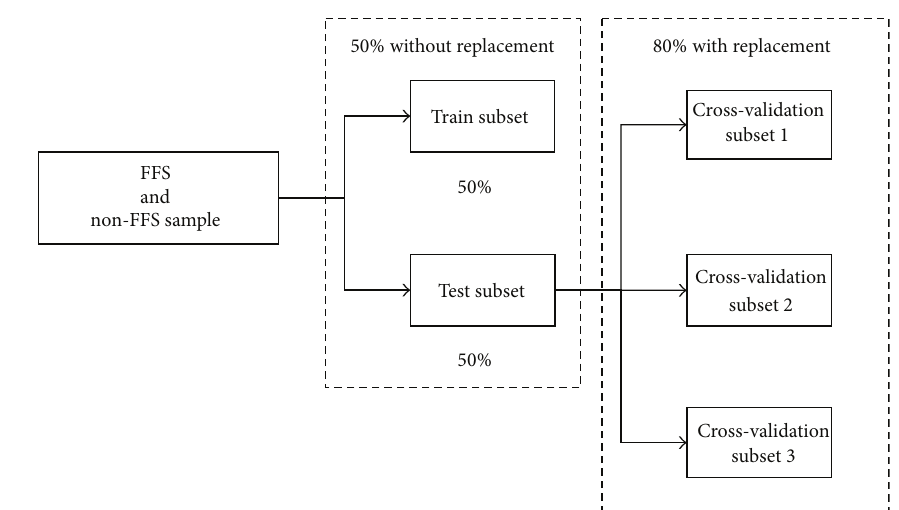
Figure 1: Train and test subsets